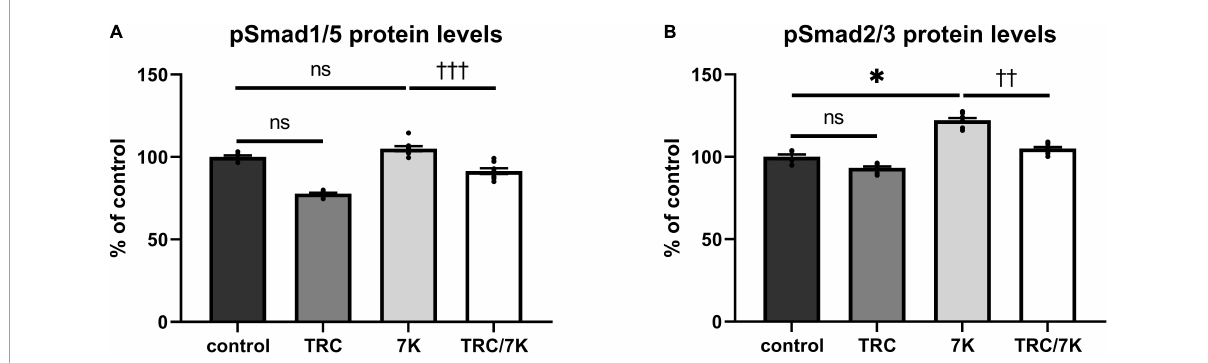
FIGURE3 Effect of TRC105 on 7K-induced Eng signaling pathway in HAoECs. (A) pSmad1/5 protein levels; (B) pSmad2/3 protein levels. To analyze Smad signaling, cells were serum-starved in EBM-2 medium for 22 h and then pretreated with 300 µ g/ml TRC105 for 90 min. HAoECs were stimulated with 10 µ g/ml 7K for 30 min after TRC105 pretreatment. The data are presented as mean ± S.E.M ( n = 6). ns, p ≥ 0.05; * p < 0.05, using Kruskal–Wallis test for comparisons among control, TRC105, and 7K, and †† p < 0.01; ††† p < 0.001, using Mann–Whitney test for comparison between 7K vs